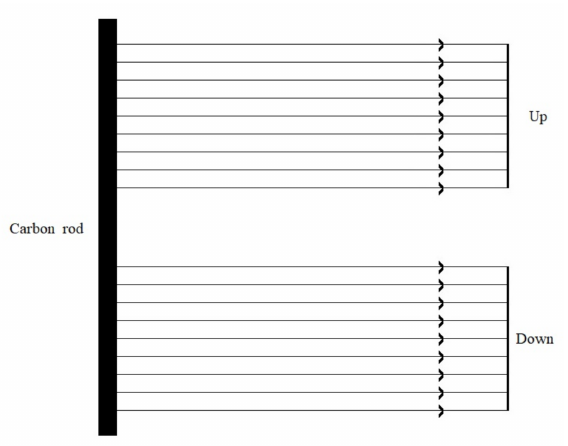
Figure 3. Conductive model of electrodeposition with dual working electrodes.